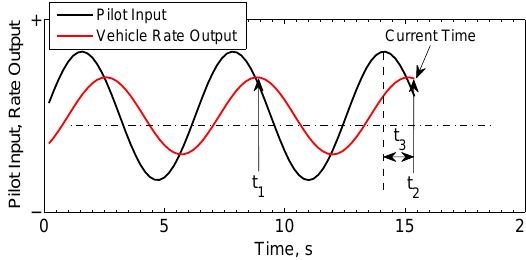
Figure 7. Calculation of last oscillation cycle and